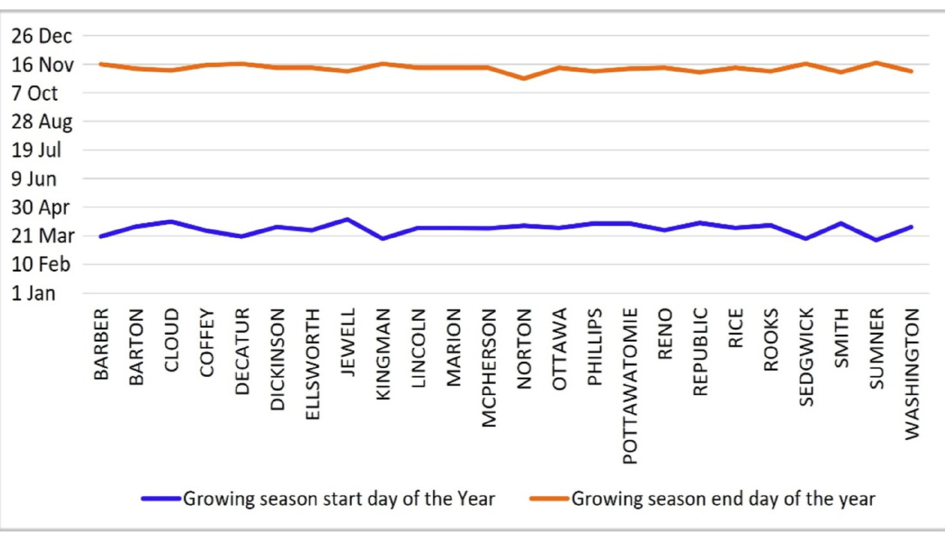
Figure 5. The alfalfa growing season start and end days for each selected county, estimated using 30 yrs (1988–2017) daily maximum and minimum temperature of each county and the alfalfa base temperature (5 °C).